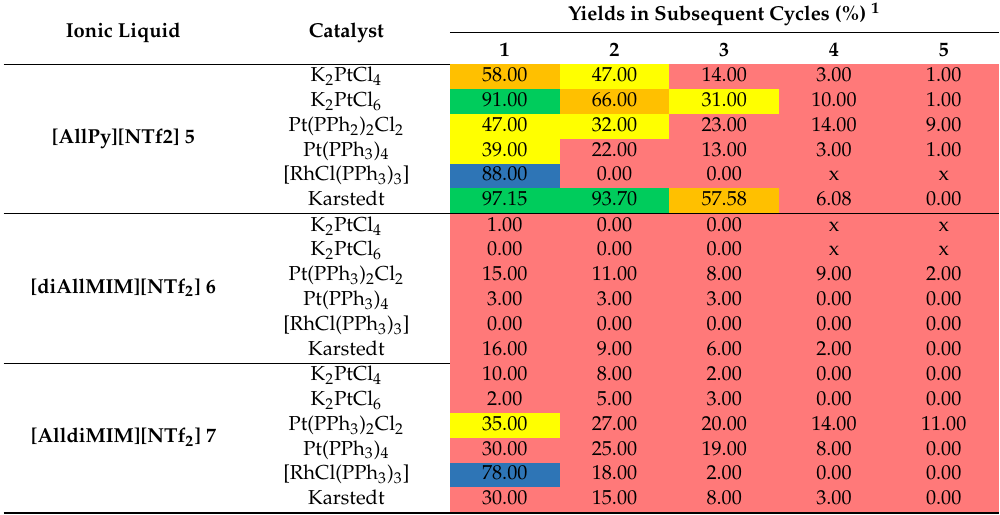
1 Yields color code: green >90%; blue 70–90%; orange 50–70%; yellow 30–50%; red 0–30%; [P 44414 ][NTf 2 ] tributyltetradecylphosphonium bis(trifluoromethylsulfonyl)imide; [BuPy][NTf 2 ] 1-butylpyridinium